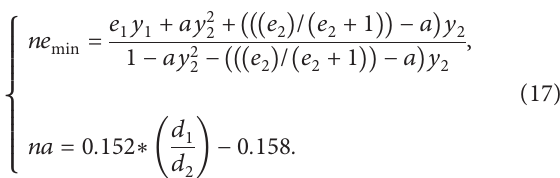
Figure 14: Comparison chart of ( a + b ) and e